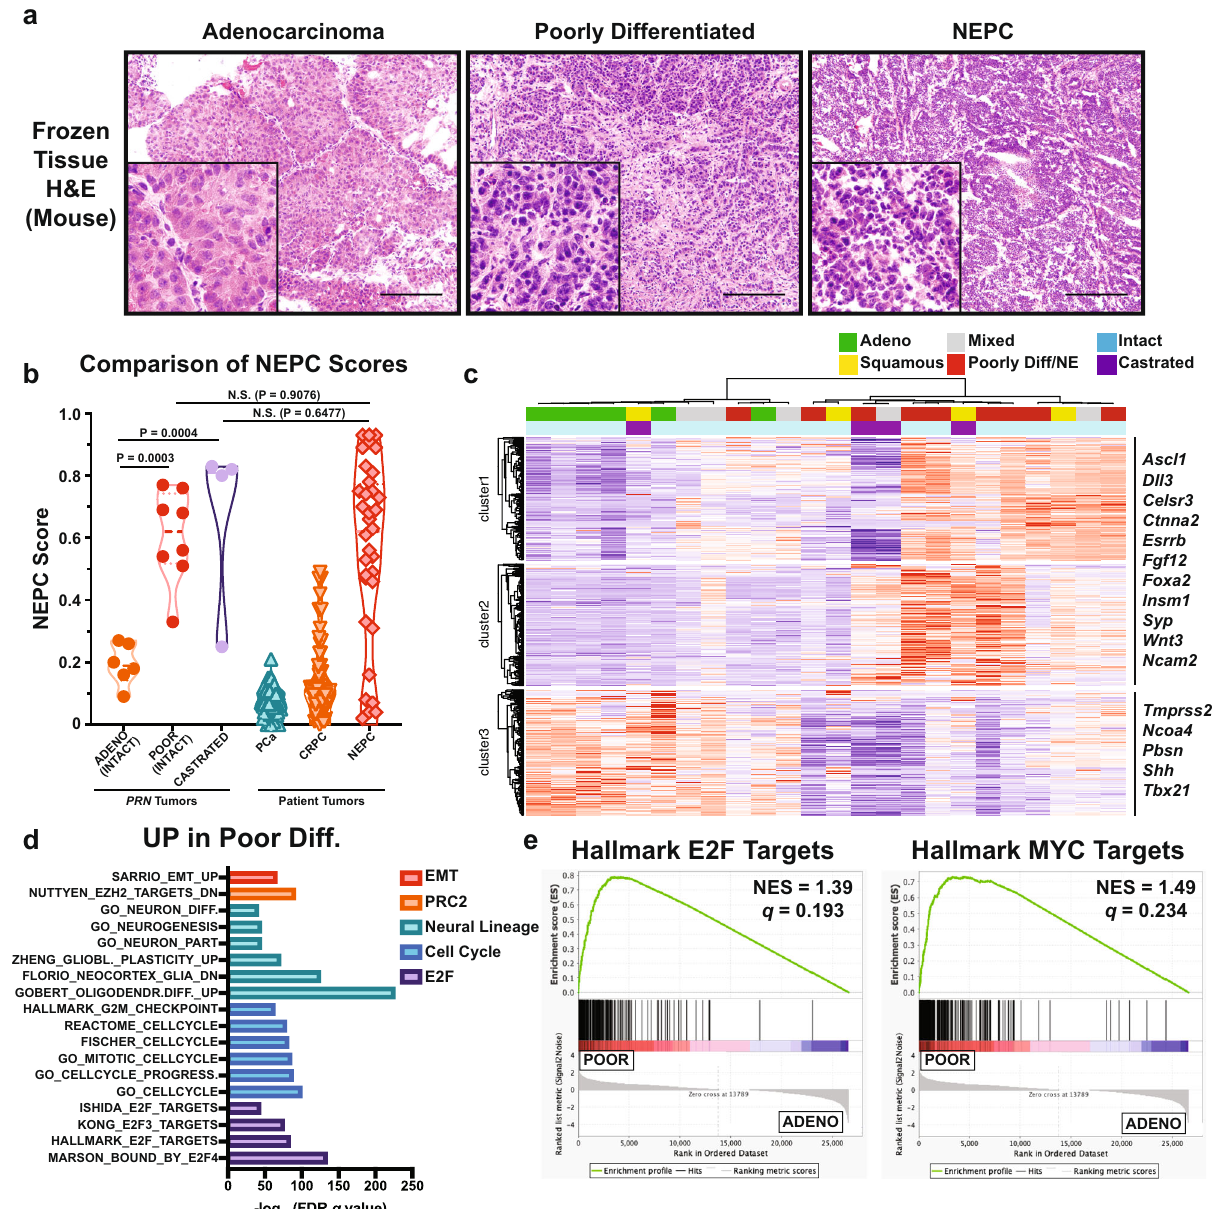
Fig. 2 Poorly differentiated tumors have molecular signatures similar to clinical NEPC. a H&E from frozen GEM tumors showing examples of adenocarcinoma, poorly differentiated, and NEPC histology. Images are representative of 20 independent mice. Scale bar: 50 μ m. b Violin plot of NEPC scores from PRN GEMs with conventional adenocarcinoma and poorly differentiated/NEPC histologies, as well as PCa, CRPC, and NEPC patient samples. Signi fi cance was calculated using one-way ANOVA with Tukey ’ s multiple comparison test. c Heatmap and hierarchical clustering of poor, squamous, adenocarcinoma, and mixed differentiation foci from GEMs based on the PRN POOR vs. PN ADENO Signature. All castrated mice are of PRN genotype. d Top gene sets related to E2F targets, cell cycle, neuronal development, epigenetic reprogramming, epithelial identity, p53 targets, and AR signaling. UP: log 2 (FC) >1.5; DOWN: log 2 (FC) < − 1.5, Benjamini-Hochberg adjusted two-sided t -test p < 0.05. e GSEA enrichment plots of Hallmark E2F Targets and Hallmark MYC Targets in poorly differentiated (POOR) vs. adenocarcinoma lesions, tumors from PRN mice contained large regions of AR- both genotypes revealed 10 major cell clusters of gene expression positive adenocarcinoma, as well as neighboring foci comprised (Fig. 3b). Differential expression analysis between clusters pro- of AR-negative, INSM1-positive cells (Fig. 3a). In order to better duced a list of the top 50 most differentially expressed genes by understand this heterogeneity we observed in the developing cluster (Fig. 3c and Supplementary Table 2), and we assigned tumors, we performed single-cell RNA sequencing (scRNA-seq) identities to each cluster using the expression of known markers on prostates collected from 8-week old PRN mice ( n = 3), as well (Fig. 3b). We restricted further analyses to include populations as age-matched PR mice ( n = 3) and sought to identify sub- that were identi fi ed as luminal epithelium, basal epithelium, or populations that may contribute to tumorigenesis. K-means neuroendocrine cells on the basis of Krt5, Krt8, Cd24a, Trp63 , clustering and UMAP projection of the combined data across and Insm1 expression. Re-clustering of this subset allowed for